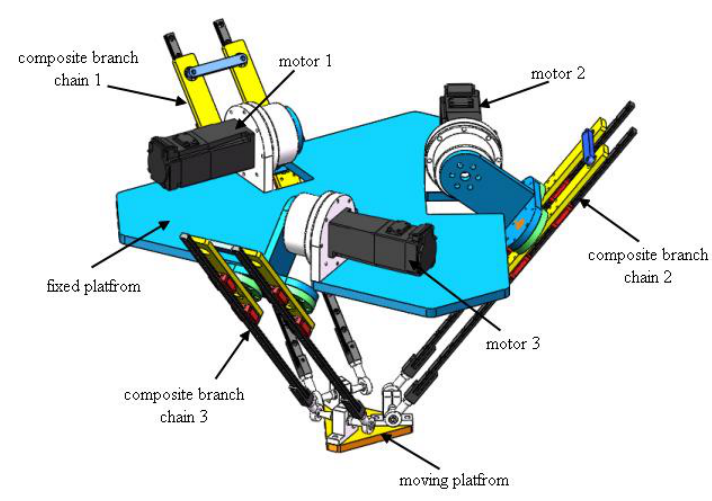
Figure 1 . PM structure .